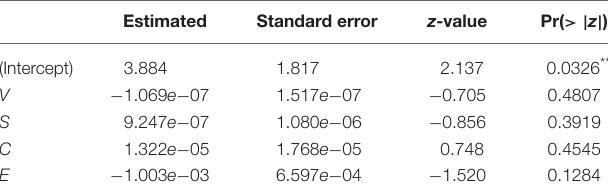
TABLE 4 | Regression results for soil management as soil factor.